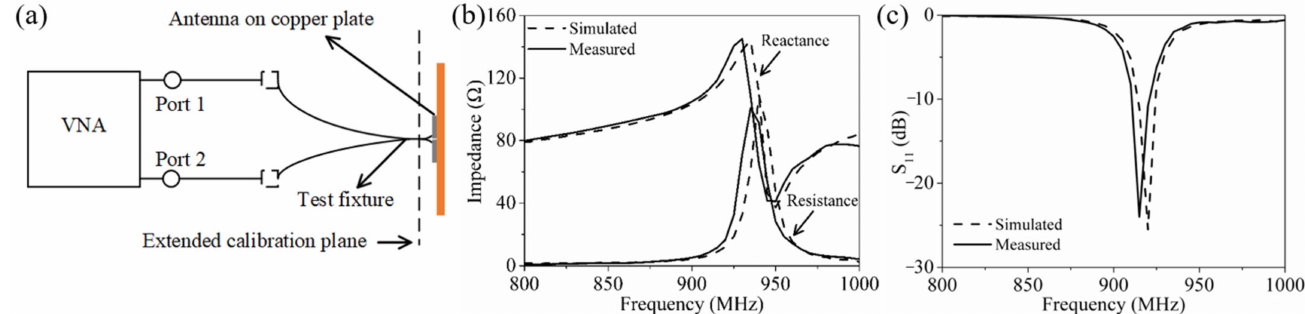
Figure 9. Antenna performance measurements: ( a ) schematic diagram; simulated and measured ( b ) complex impedance and ( c ) reflection coefficient of the antenna with optimized